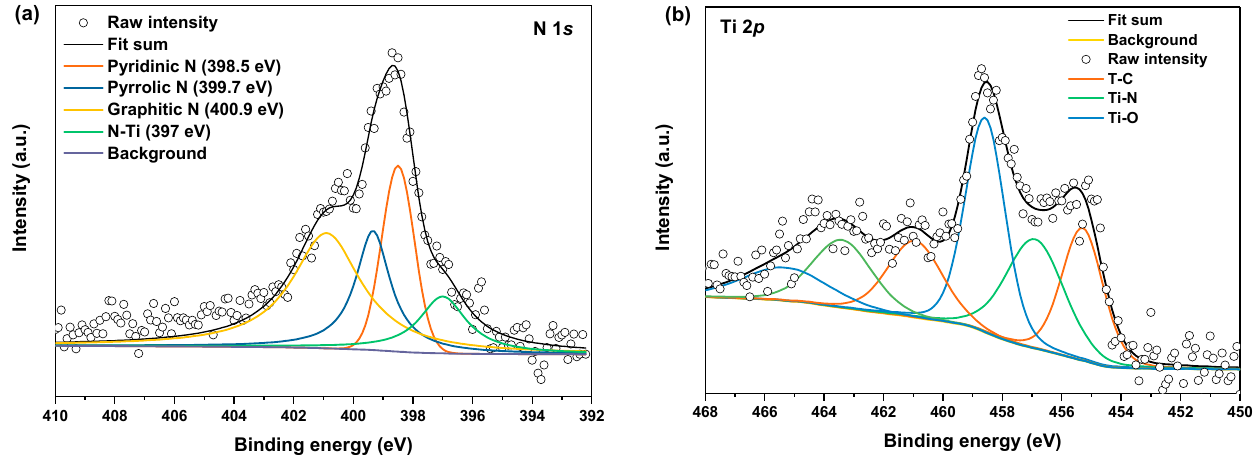
charge within hours [66], which is a severe drawback in practical application. To evaluate